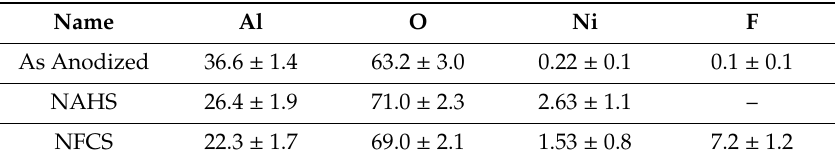
Figure 4. Estimated corrosion current density from potentiodynamic polarization curves (Figure 3) for ( a ) NAHS and ( b ) NFCS with respect to various sealing times. Table 2. Chemical composition (in at.%) of anodized aluminum alloy with nickel acetate hot sealing (NAHS) and nickel fluoride cold sealing (NFCS) analyzed by EDS.